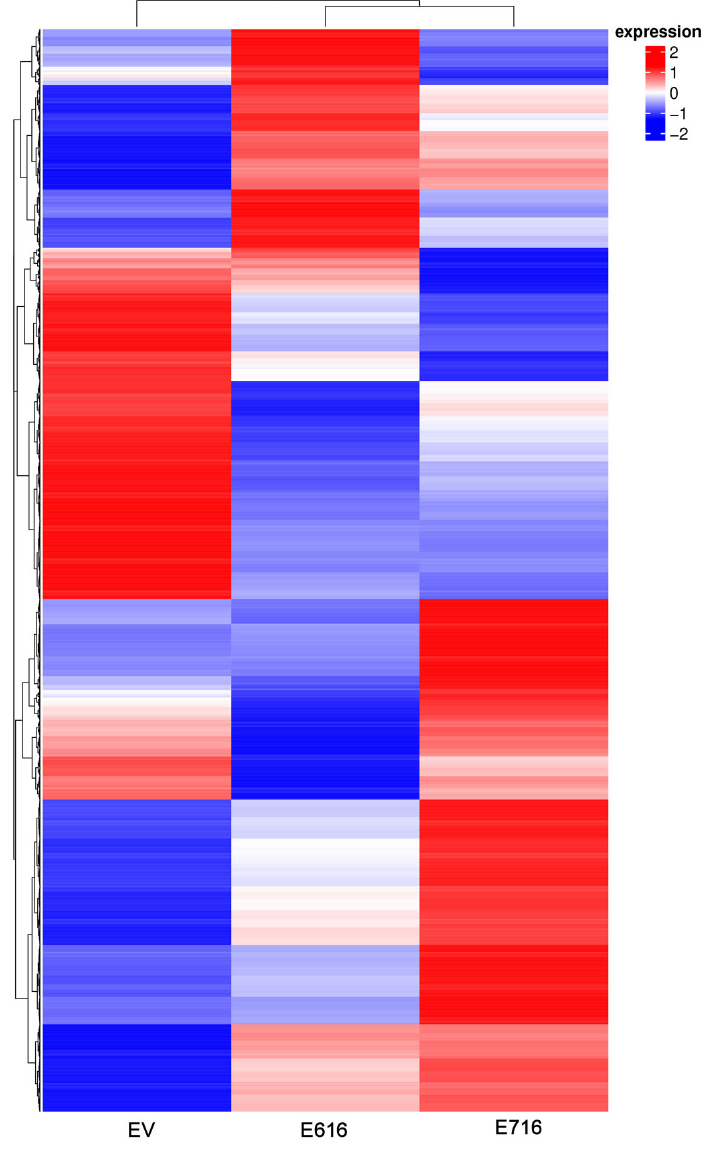
Figure 2. Gene expression patterns exhibited by C33EV, -E616, and -E716 cells. Heatmap showing the differential gene expression in Log2(FPKM+1) in the three cell groups in the columns (EV, E616, and E716). Each row represents the expression of a gene. Red color indicates increased expression levels and blue, decreased expression, while white means no significant change or the absence of data. Hierarchical clustering is shown at the top of the figure according to the transcriptional patterns of the groups (EV, E616, and E716), revealing that cells expressing the oncoproteins are closer than those with the empty vector. At the left, the clustering for differential gene expression is depicted.